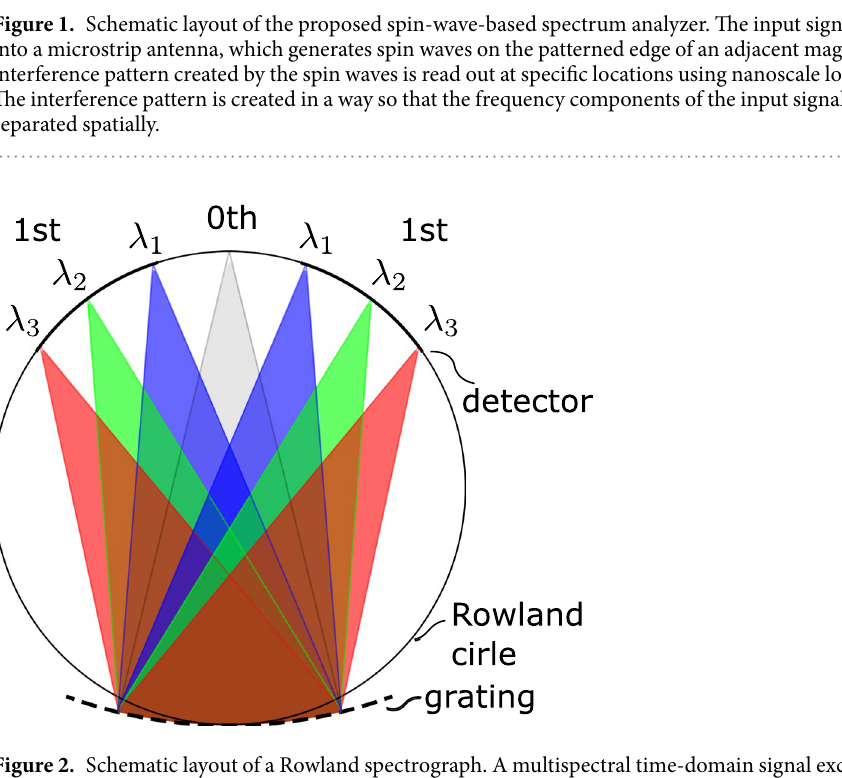
Figure 2. Schematic layout of a Rowland spectrograph. A multispectral time-domain signal excites waves at the grating, and the wavefronts interfere in such a way that the spectral decomposition of the signal appears as interference maxima on the Rowland